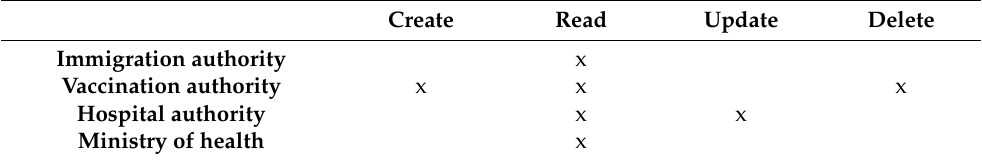
Table 2. Access control privileges by different